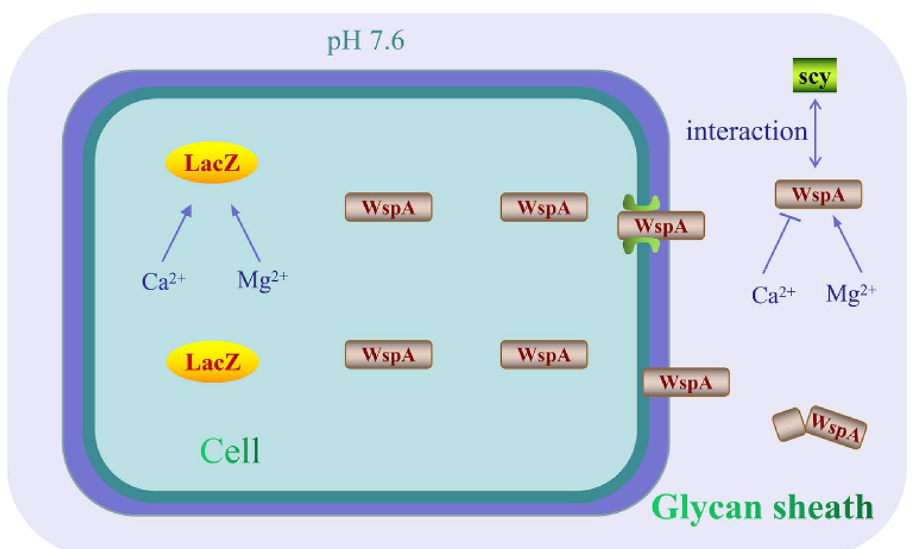
Figure 7. An illustration of the two β-galactosidases LacZ and WspA in a cell of N. flagelliforme . LacZ is located intracellularly. WspA is stored intracellularly, but can be secreted into the glycan sheath upon rehydration. The activities of both enzymes are promoted by Mg 2+ , while Ca 2+ is inhibitory for WspA. In the glycan sheath, the activity of WspA may also be affected by the extracellular pigment scytonemin and its own hydrolysis. scy